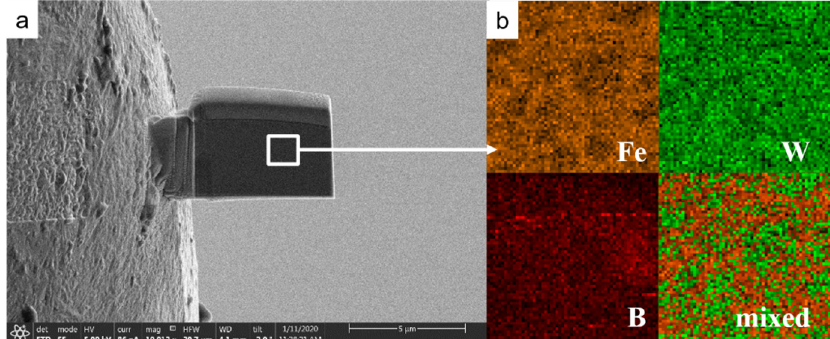
Figure 6. ( a ) FIB sample image and ( b ) EDS area microanalyses of as-atomized Fe-W-B amorphous powder.